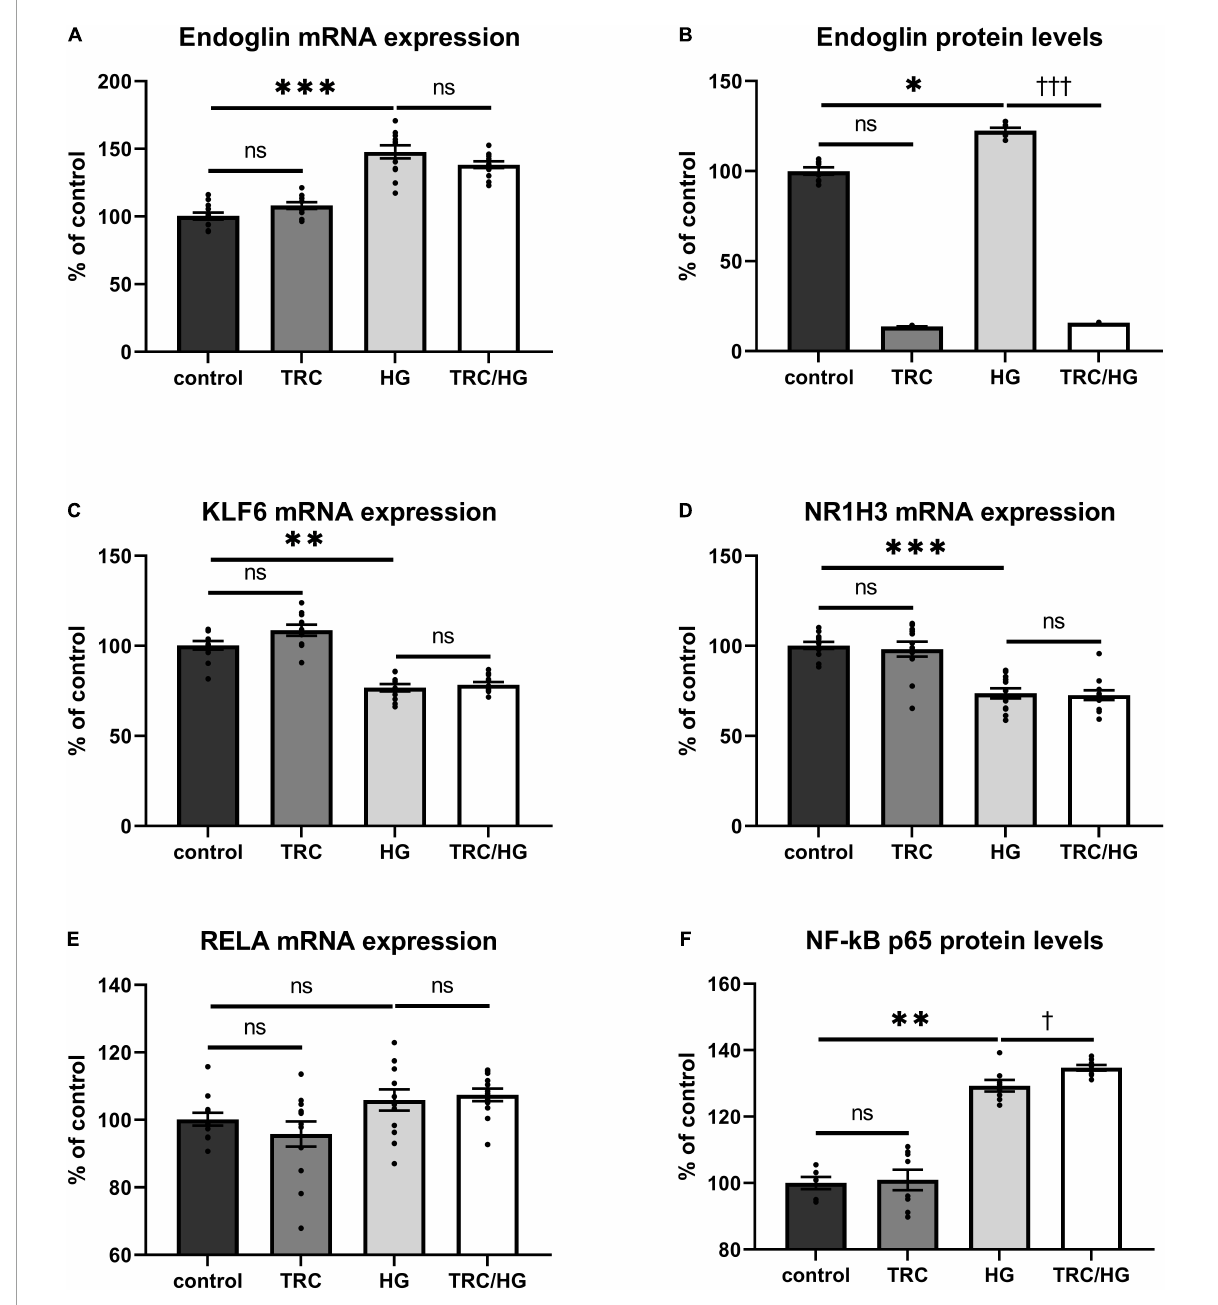
FIGURE6 Effect of TRC105 on hyperglycemia-induced mRNA and protein expression of Eng, and on the Eng transcription factors KLF6, NR1H3, and RELA in HAoECs. (A) Eng mRNA expression. (B) Eng protein levels. (C) KLF6 mRNA expression. (D) NR1H3 mRNA expression. (E) RELA mRNA expression. (F) NF- κ B p65 protein levels. For the detailed experimental design, please see Figure 1 . The data are presented as mean ± S.E.M ( n = 6). ns, p ≥ 0.05; * p < 0.05; ** p < 0.01; *** p < 0.001, using Kruskal–Wallis test for comparisons between control, TRC, and HG, and † p < 0.05; ††† p < 0.001, using Mann–Whitney test for comparison between HG vs .